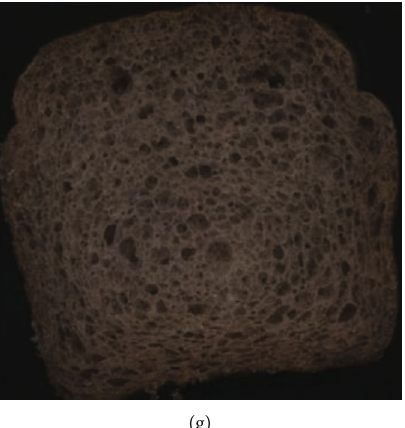
Figure 1: Digital images of slices of the investigated breads: (a) K control bread, (b) SBK 0/80, (c) SB10/80, (d) SB20/80, (e) SBK 0/120, (f) SB 10/120, and (g) SB 20/120. SBK 0/80, SBK 0/120, starch bread with 10% rice extrudate processed at 80 and 120 ° C, respectively; SB10/80,